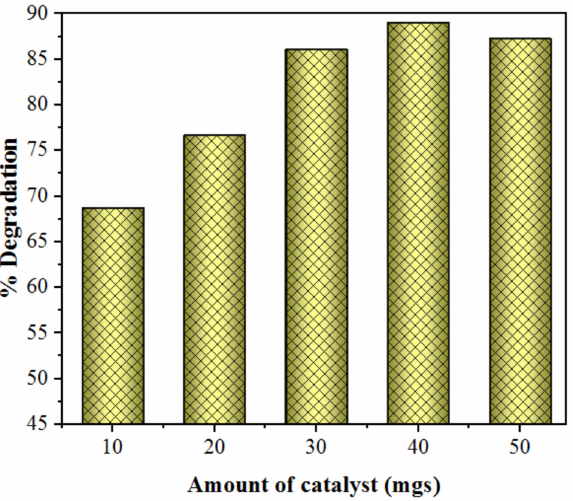
Figure 13. Effect of variation of the amount of Mn 2+ :ZnS Qds catalyst on the sonophotocatalytic degradation of SDB under optimum conditions (15 mL of SDB 70 ppm, pH 6, 75 min irradiation, 40